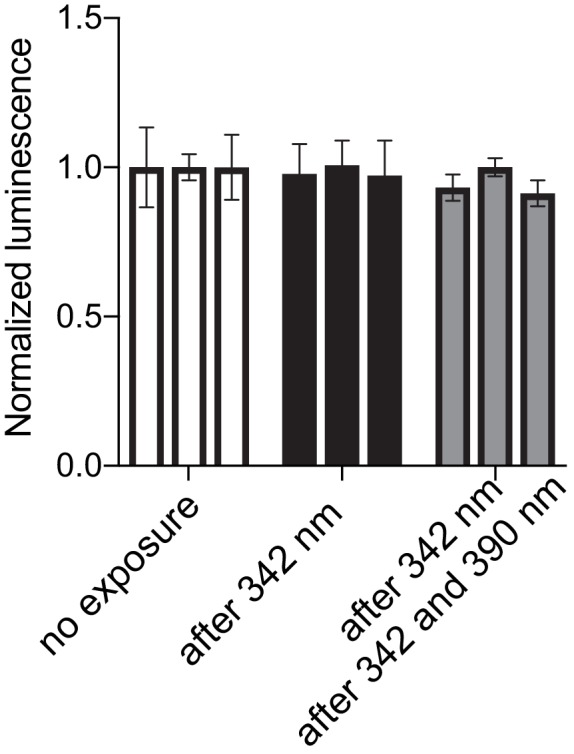
Lack of photoactivity of the Were-1-Fluc G69C variant.Luciferase expression (± SEM) by the Were-1-Fluc G69C mutant, showing no significant change in expression after exposure to 342 nm (black, second and third bar), or 342 nm followed by 390 nm (second and third gray bar, respectively) compared to unexposed controls (clear).Figure 3—figure supplement 4—source data 1.Lack of photoswitching of the G69C variant of Were-1.